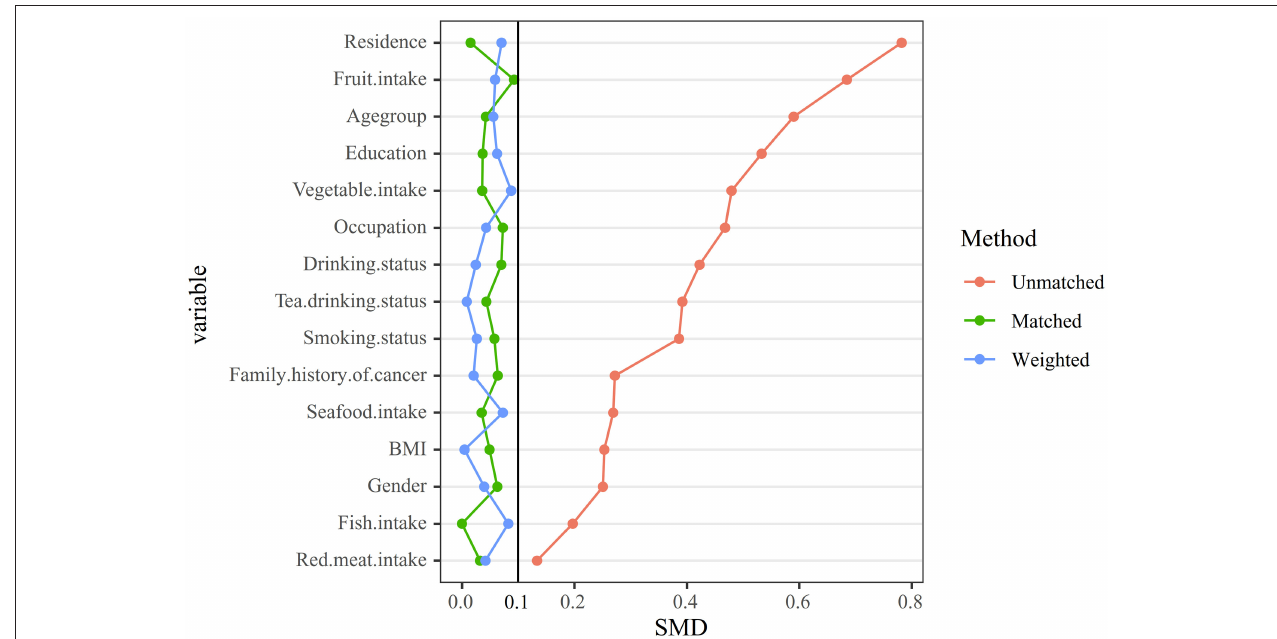
FIGURE 3 | Comparison of the distribution of matching factors between cases and controls before and after matching. Group differences were assessed using standardized mean differences (SMD), with an SMD value of 0.1 considered balanced.